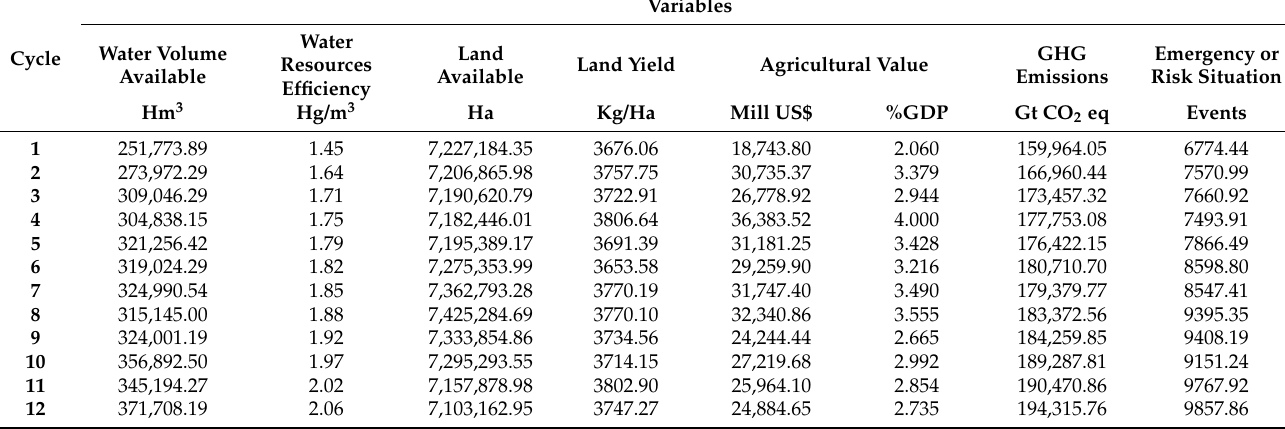
Table 6. Values of interest variables for each simulated